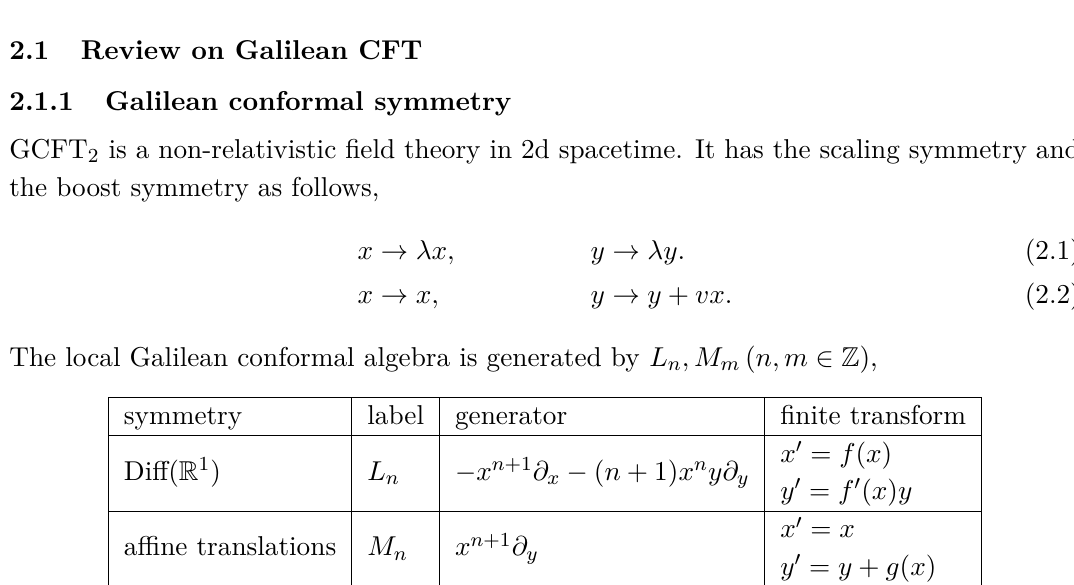
Table 1. The generators of global Galilean conformal group. “SCT” denotes “special conformal